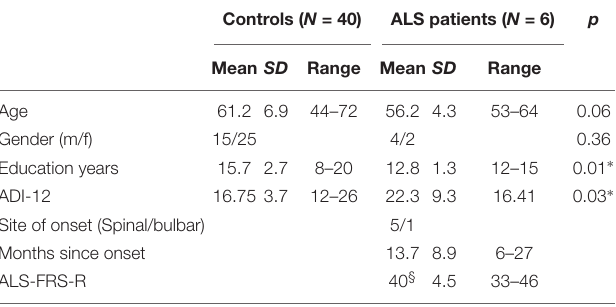
§ indicates moderate physical impairment. Chi 2 test for gender and site of onset and Mann–Whitney U-test for all other comparisons were used. ∗ p <